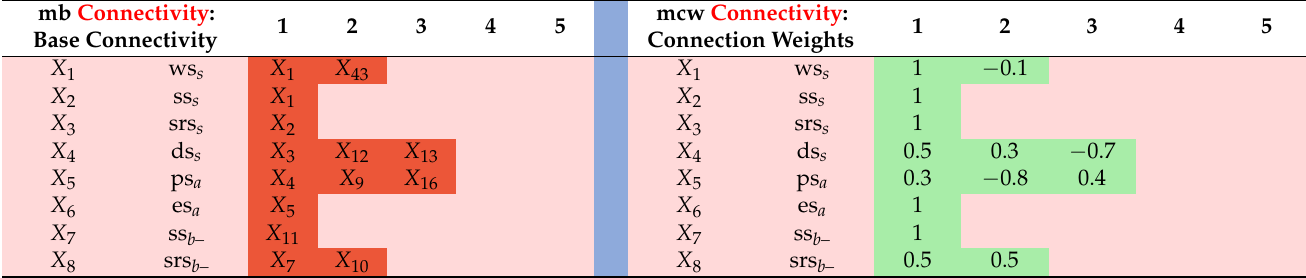
Table A1. Role matrices for